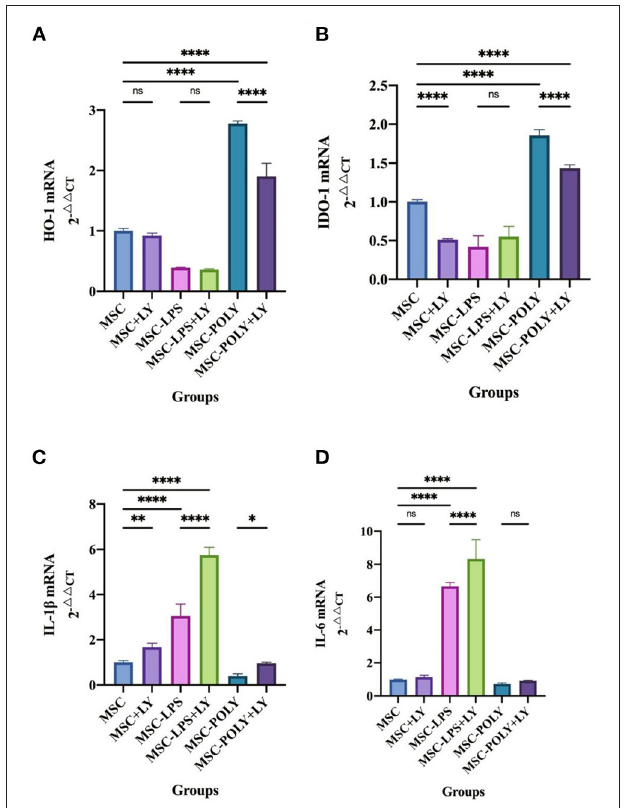
FIGURE 5 | mRNA expression of cytokines in mesenchymal stem cells after addition of the PI3K inhibitor. (A) HO-1 mRNA expression in mesenchymal stem cells of each experimental group. (B) IDO-1 mRNA expression in mesenchymal stem cells of each experimental group. (C) IL-1 β mRNA expression in mesenchymal stem cells of each experimental group. (D) IL-6 mRNA expression in mesenchymal stem cells of each experimental group. Values were expressed as mean ± standard deviation (mean ± SD), n = 6, ns = not statistically significant, * P < 0.05, ** P < 0.01, **** P < 0.0001.